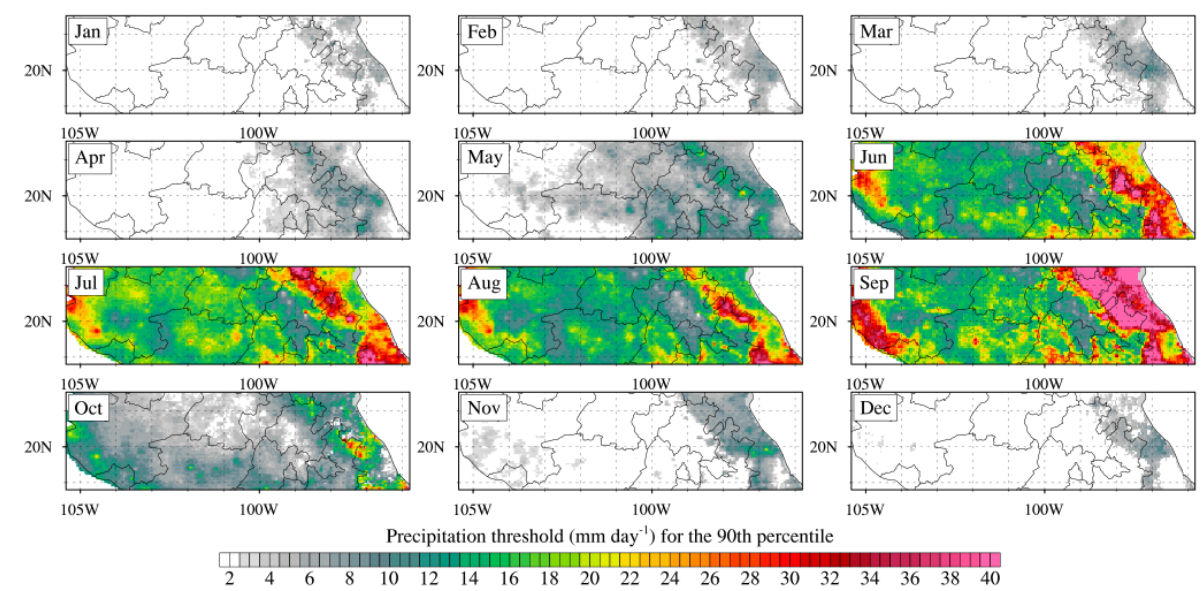
Figure 5. Monthly distribution of precipitation thresholds (mm/day) for the 90th percentile based on CHIRPS data (2008–2017) with a horizontal resolution of 0.05